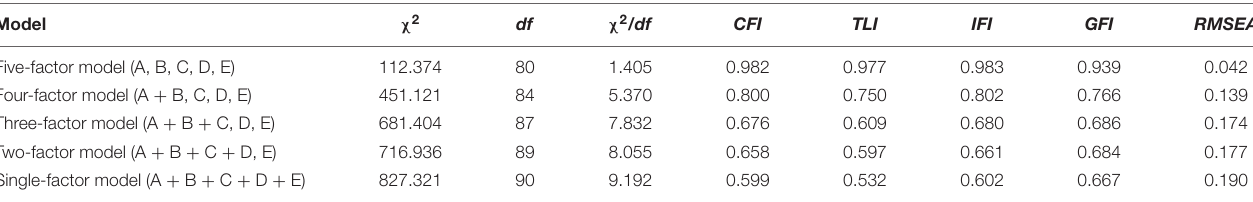
TABLE 2 | Confirmatory factor analysis (CFA).